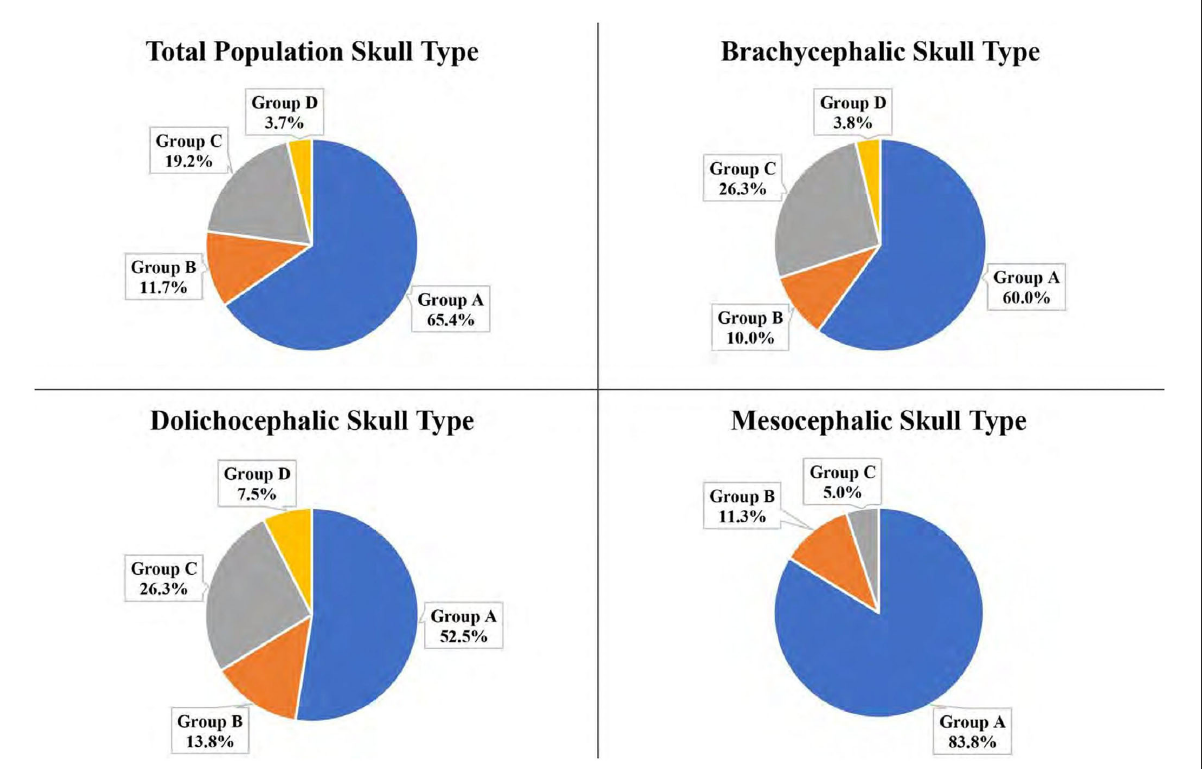
FIGURE9 Portion of the IOC within Section 5 at the mesial roots of the P4 for the total population and the three different skull types: Group A: No IOC in Section 5; Group B: 0 < IOC ≤ 1/3; Group C: 1/3 < IOC ≤ 2/3; Group D: 2/3 < IOC < 1; Group E: Entire IOC in Section 5. *Groups not pictured had